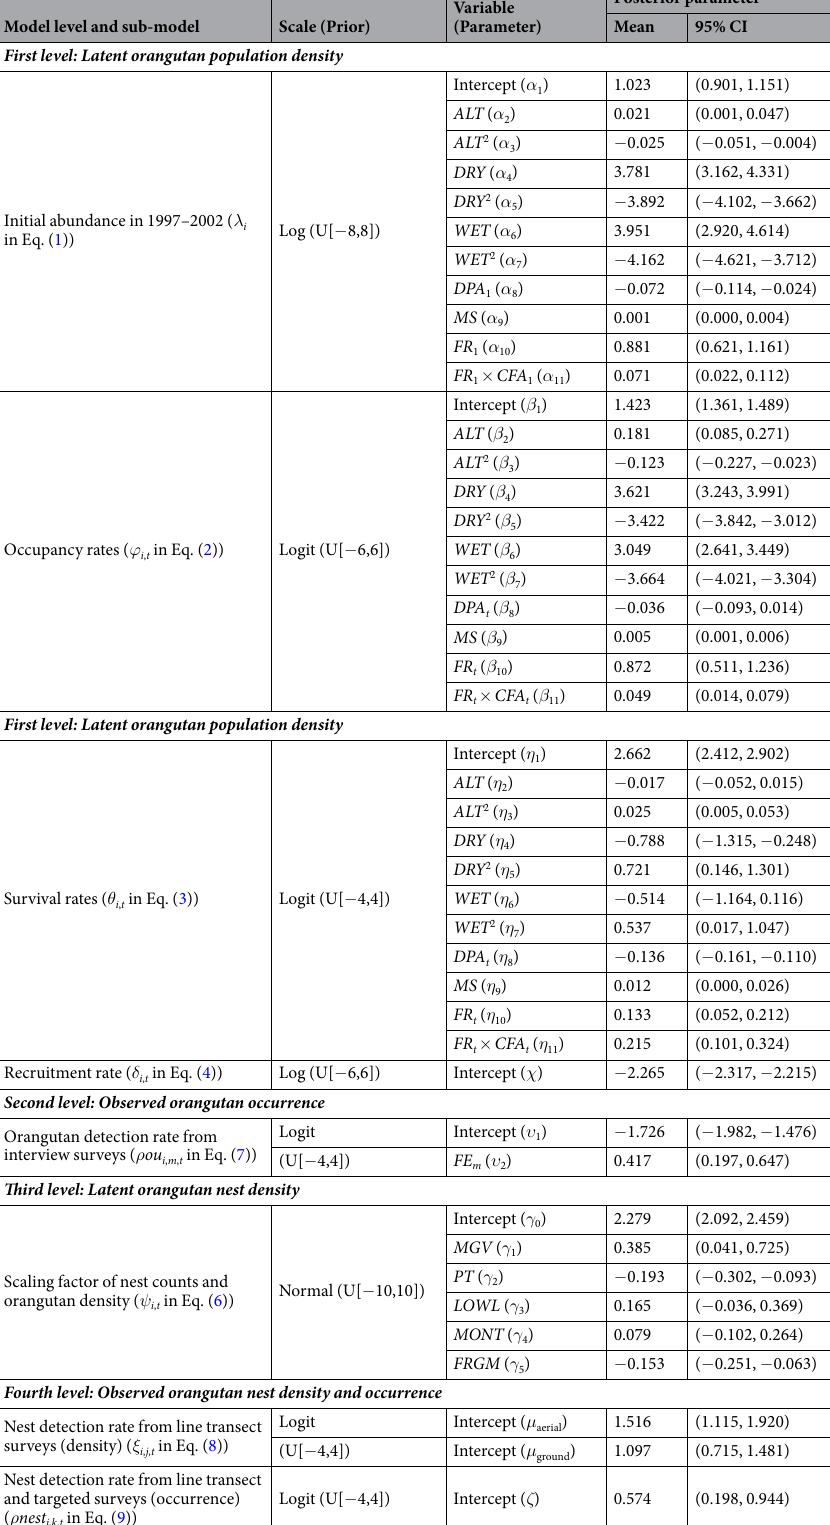
Table 2. Posterior means and the 95% credible interval (CI) of the mean for each parameter explaining the latent orangutan population density (first level of the orangutan dynamic abundance model), the observed orangutan occurrence (second level of the orangutan dynamic abundance model), latent orangutan nest density (third level), and the observed orangutan nest density and occurrence (fourth